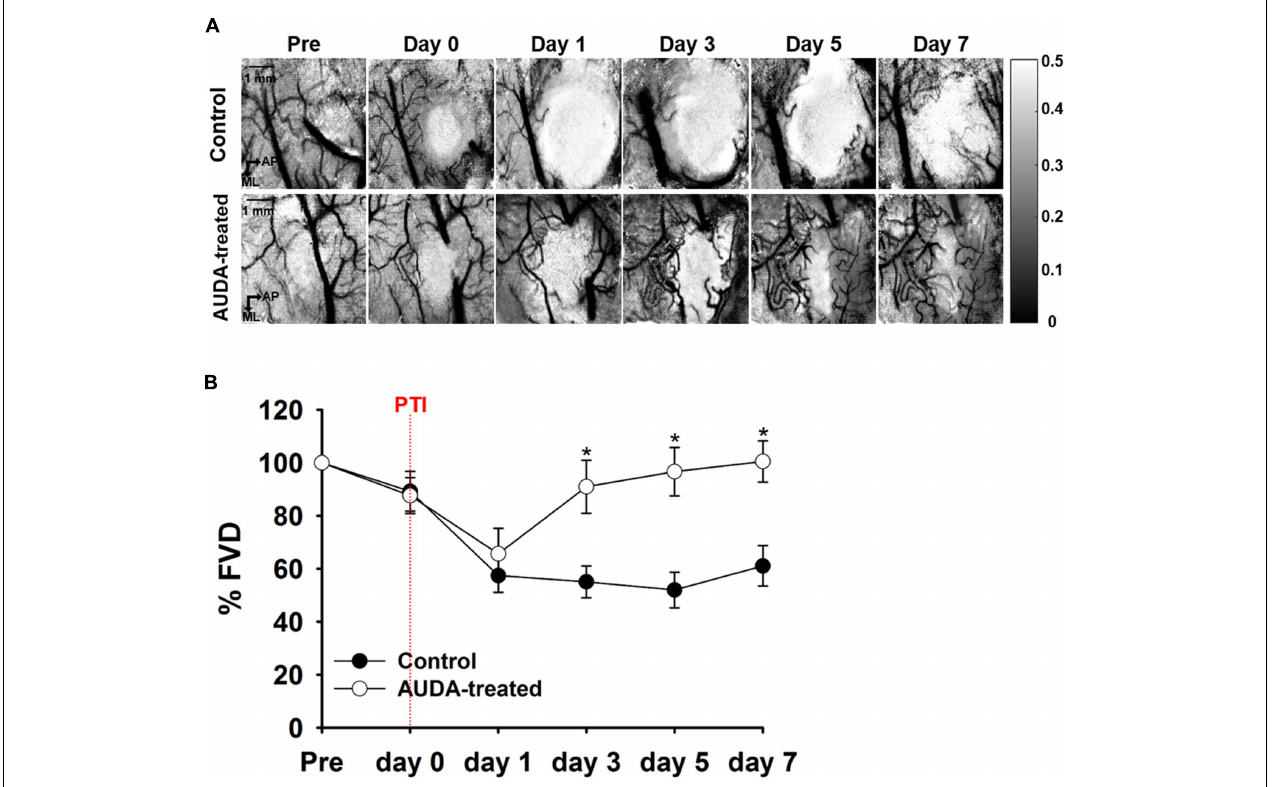
FIGURE 5 | Comparison of %FVD in the observation window after PTI stroke. (A) In-vivo LSCI images over 7 days following stroke. The scale bar is 1 mm. (B) The %FVD was significantly higher in the AUDA-treated group than in the control group from post-PTI stroke day 3. Significant differences between groups are indicated by * p < 0.05 (Mann–Whitney U -test). Data are presented as the mean ± SEM. N = 10 for each group. The red dotted line indicates the time of PTI stroke